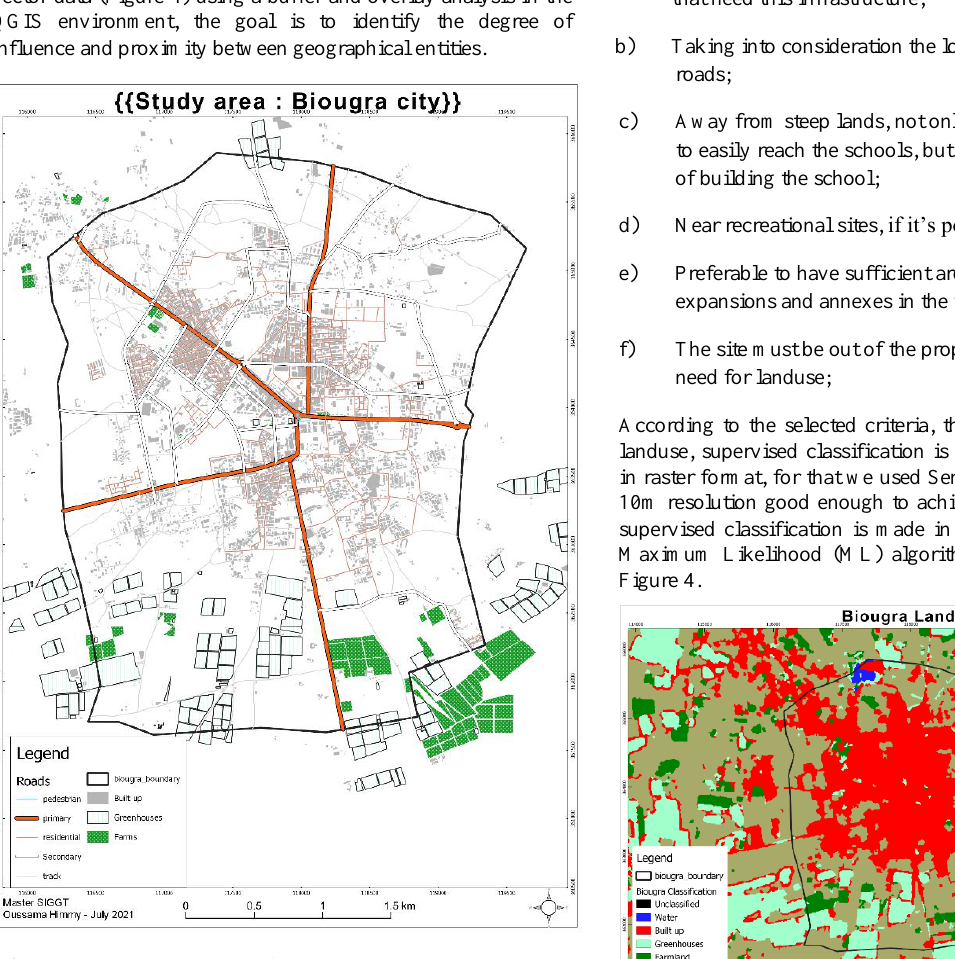
Figure 3 . An overview map of the study area and essential data used.